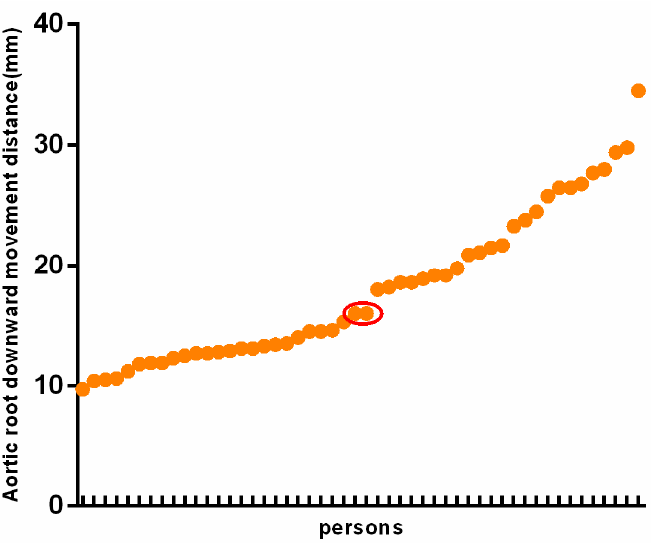
Figure 2. Data of aortic root downward movement in transthoracic echocardiographic in pre-experiment. The red elliptical ring is median.